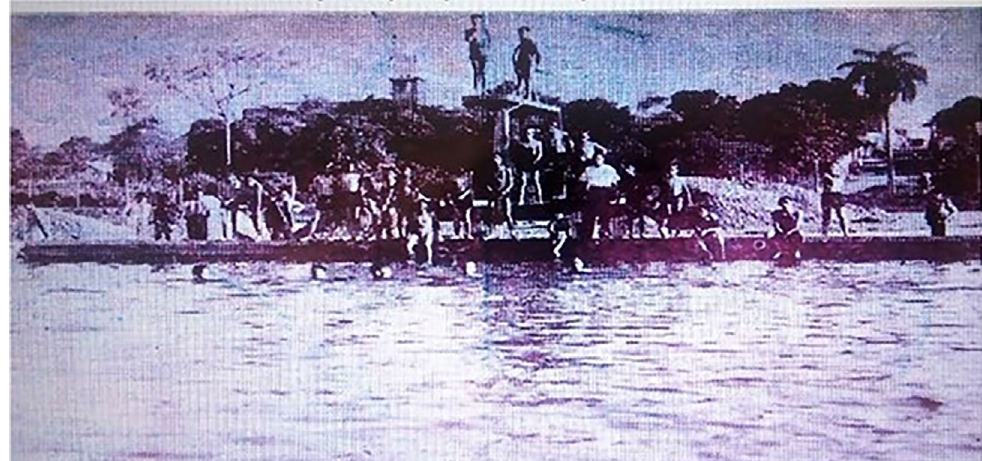
Figure 4 - The Sports Square pool in 1940. Source: Revista Montes Claros (Minas Gerais), No. 2, October 1940, page 36.